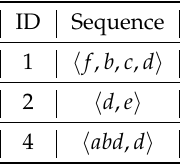
Figure 3. Example input sequences for demonstration of the pattern growth approach.